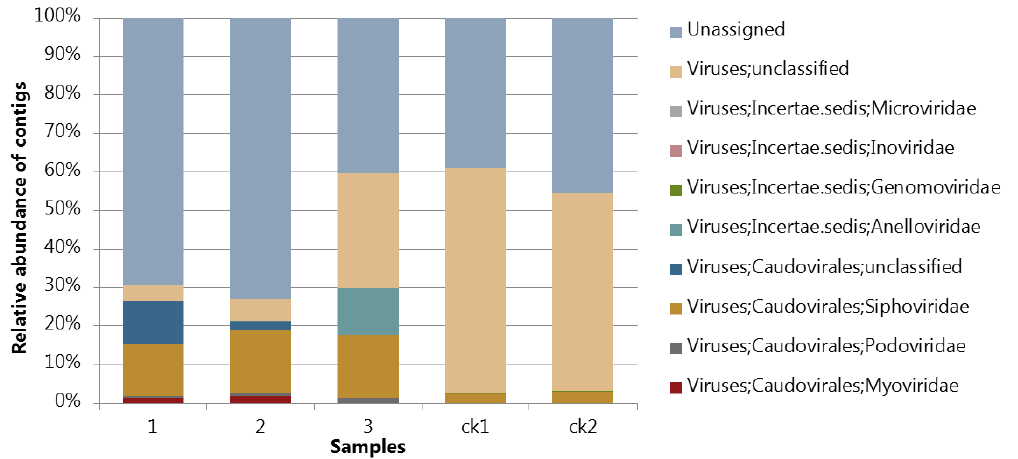
Figure 3. Taxonomic distribution (relative abundance) of the sequenced viromes. The relative distribution is described at the taxonomical level of orders. Taxonomy of contigs was determined by querying the viral contigs against a database containing taxon signature genes for virus orthologous group hosted at www.vogdb.org. The unassigned category is the contigs that have no relation to any known classified sequences.